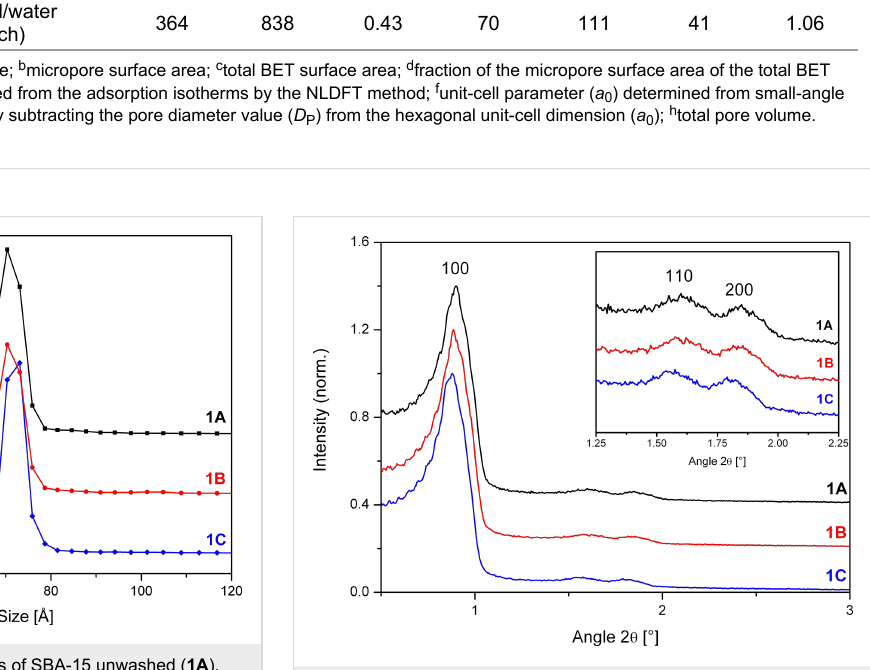
influences on the synthesis were examined and excluded: (i)